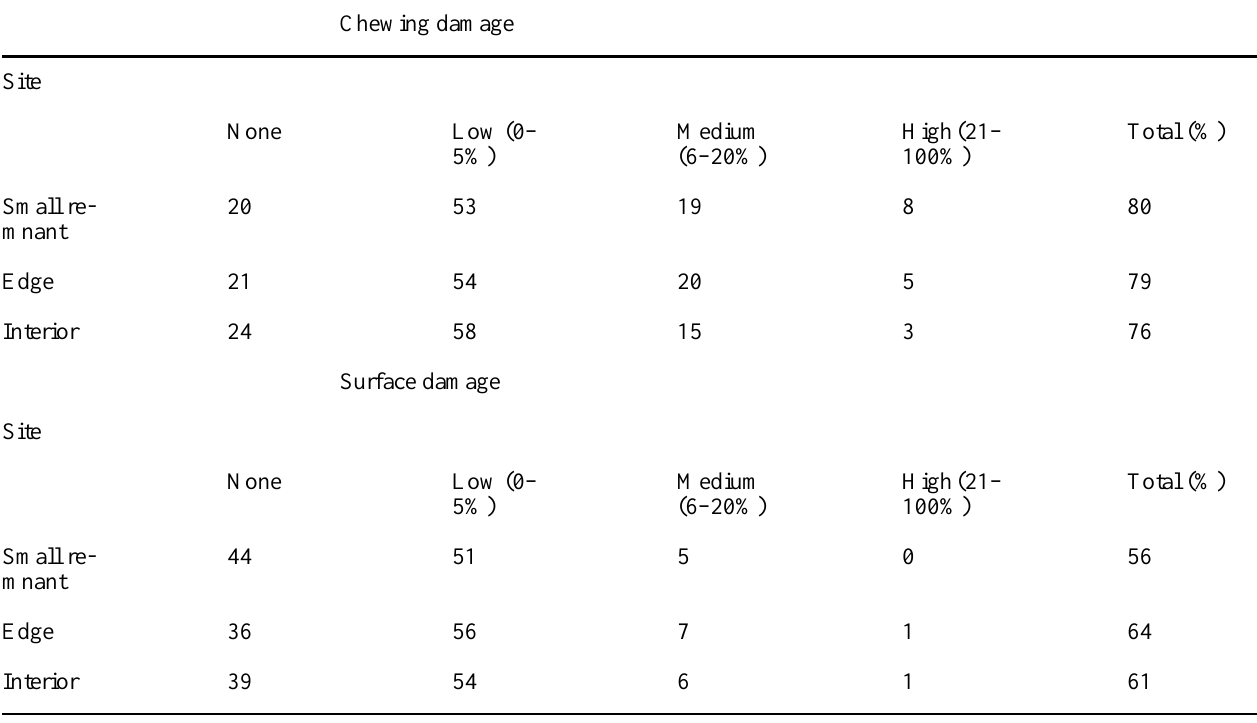
Table 1. Percentage of leaves showing signs of damage in each category (no damage, low, medium, and high) for both chewing and surface damage in small remnant, edge, and interior sites ( n = 5 sites/treatment). Chewing